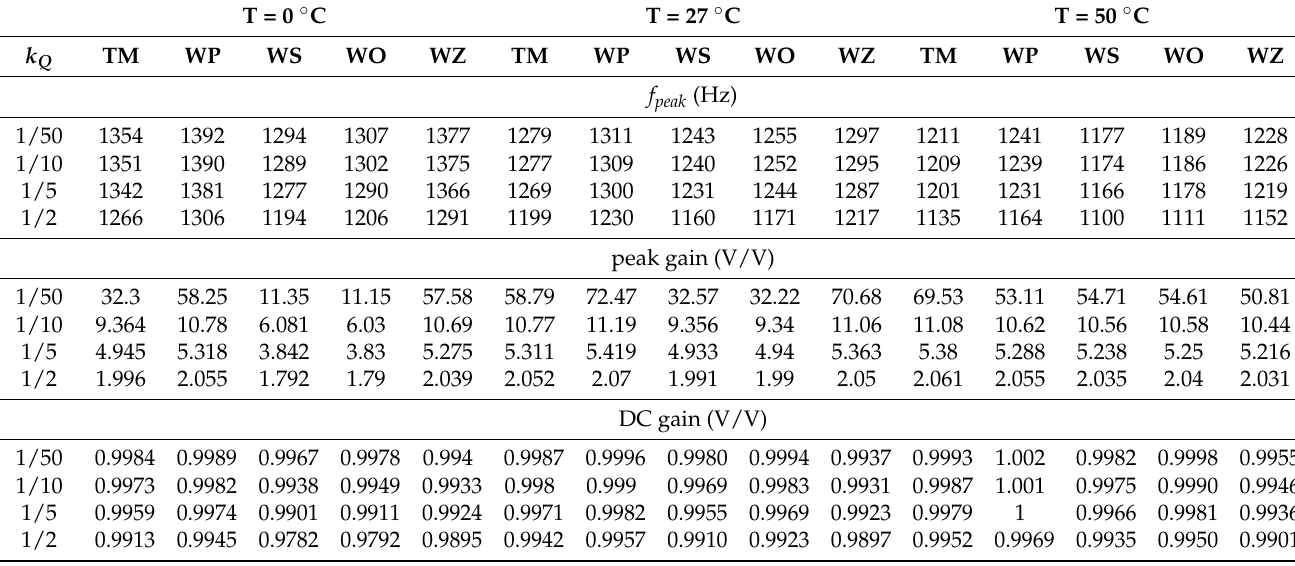
Table A2. Corner simulation results for the middle-band filter at V DD of 0.475